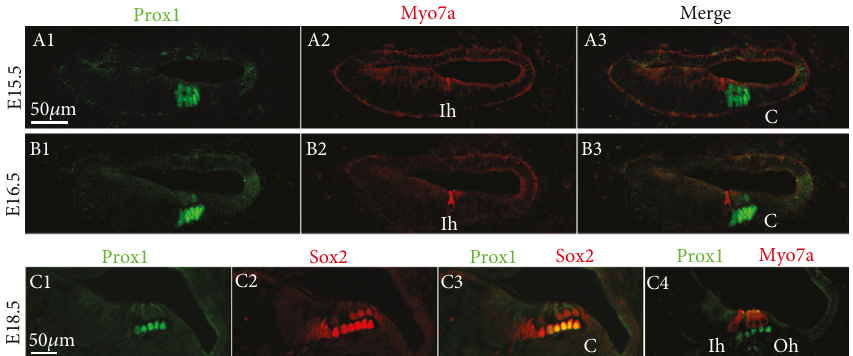
Figure 4: Prox1 gene expression patterns in the cochlea. Immuno fl uorescence of Prox1 (green) and myosin7a (red) in the cochlea at E15.5, E16.5, and E18.5. Scale bar =25 μ m.